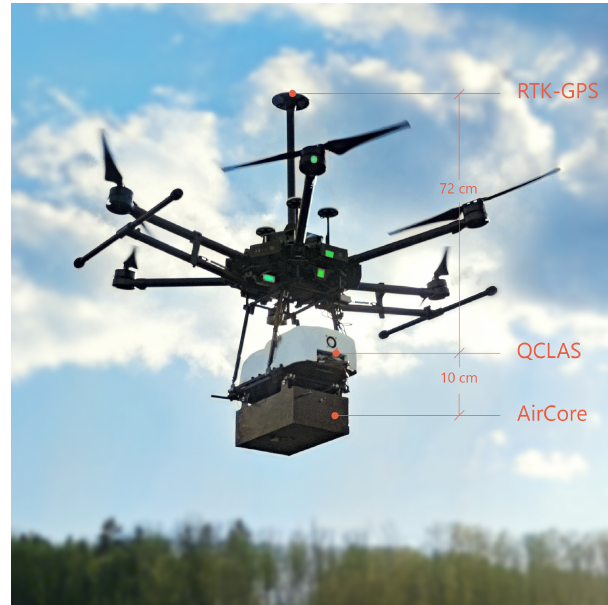
Figure 1. The embedded UAV system used for CH 4 detection: the QCLAS analyser and the active AirCore sampling system are mounted below a Matrice 600 DJI hexacopter equipped with an RTK-GPS